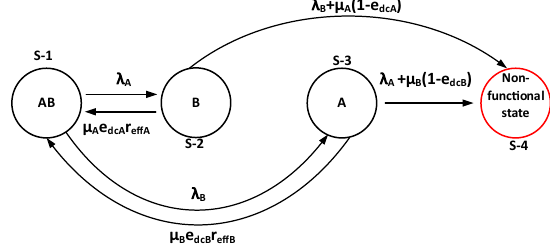
Fig. 3 Markov process ‘one-out-of-two’ voting